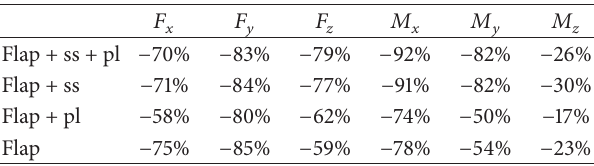
Table 3: Reductions of hub loads with feedback